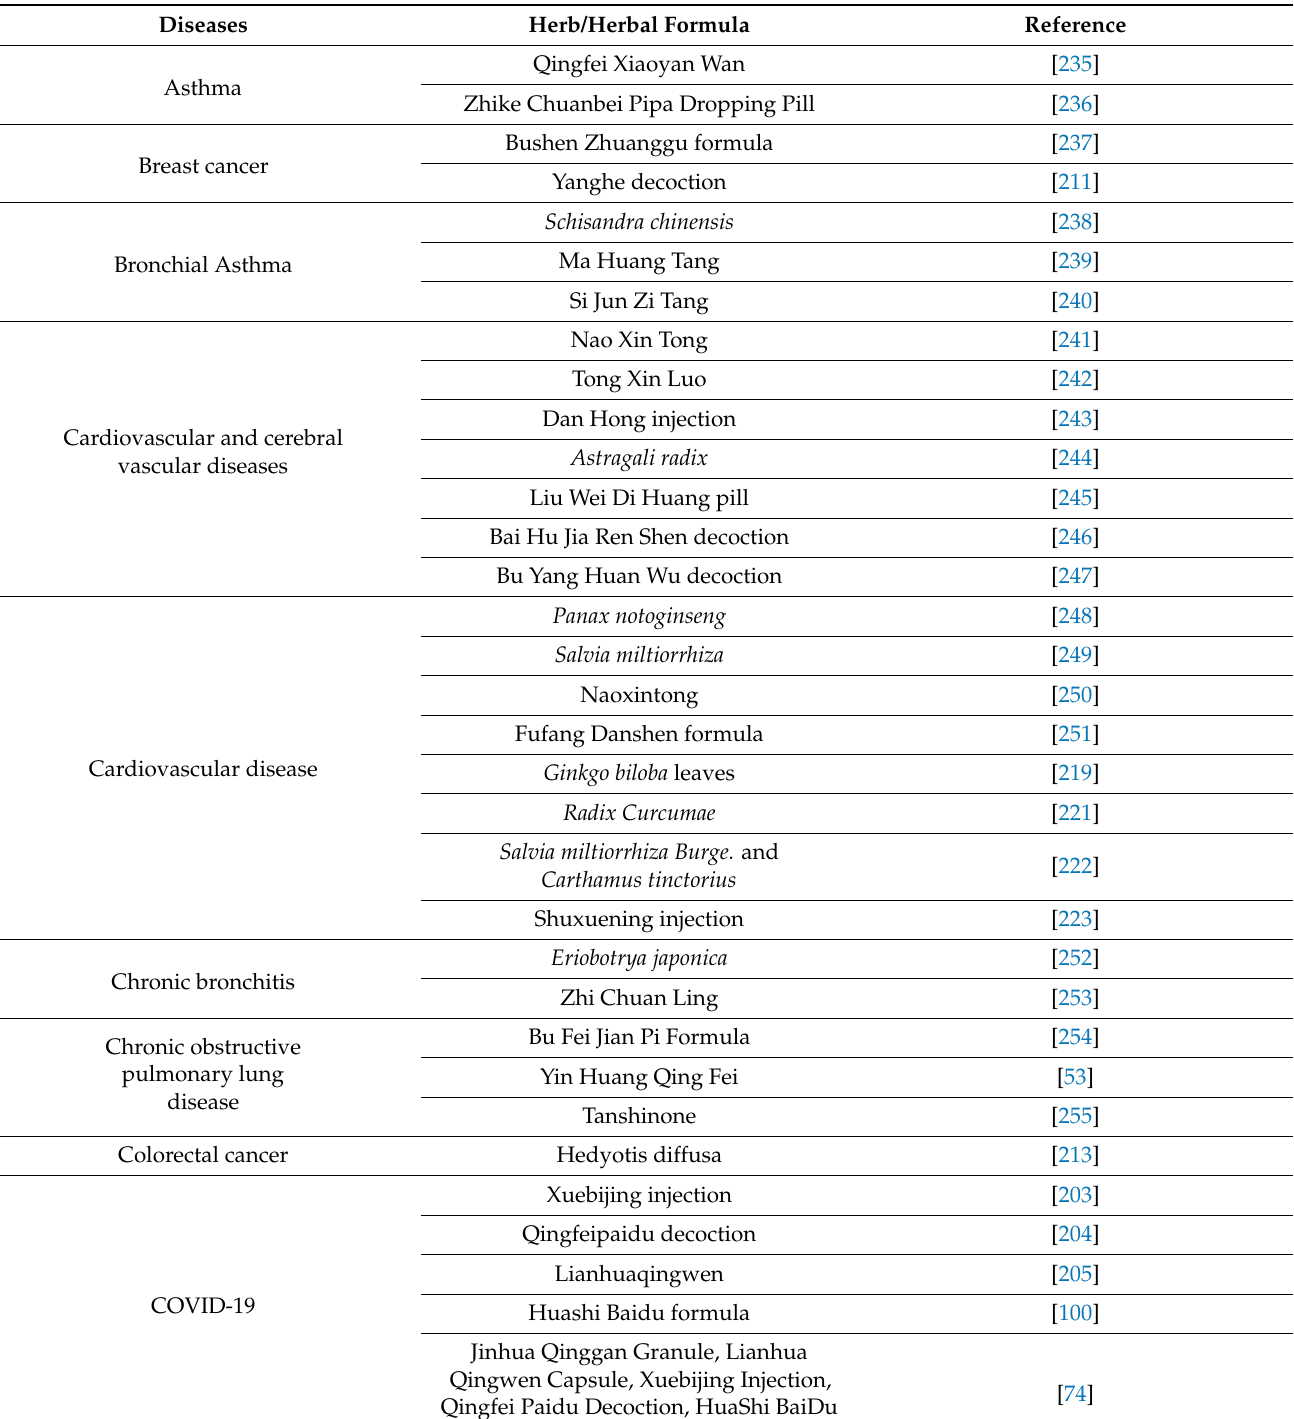
Table 2. Application of network pharmacology for treatment of diseases using herb/herbal